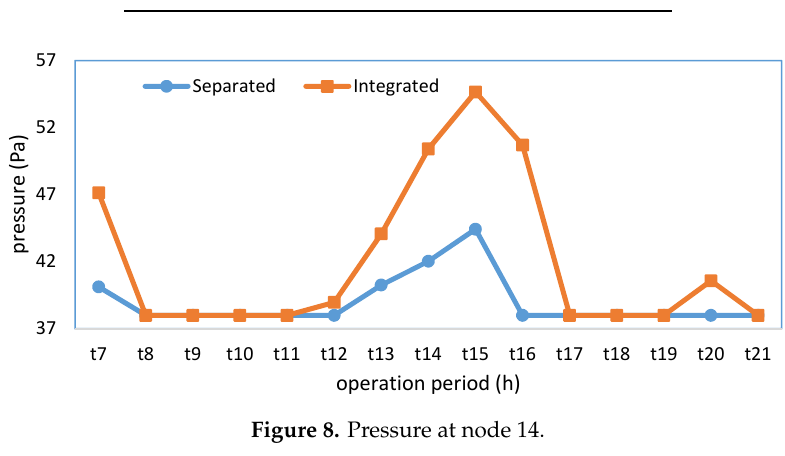
Table 6. Commitment status of GFPPs in integrated method.